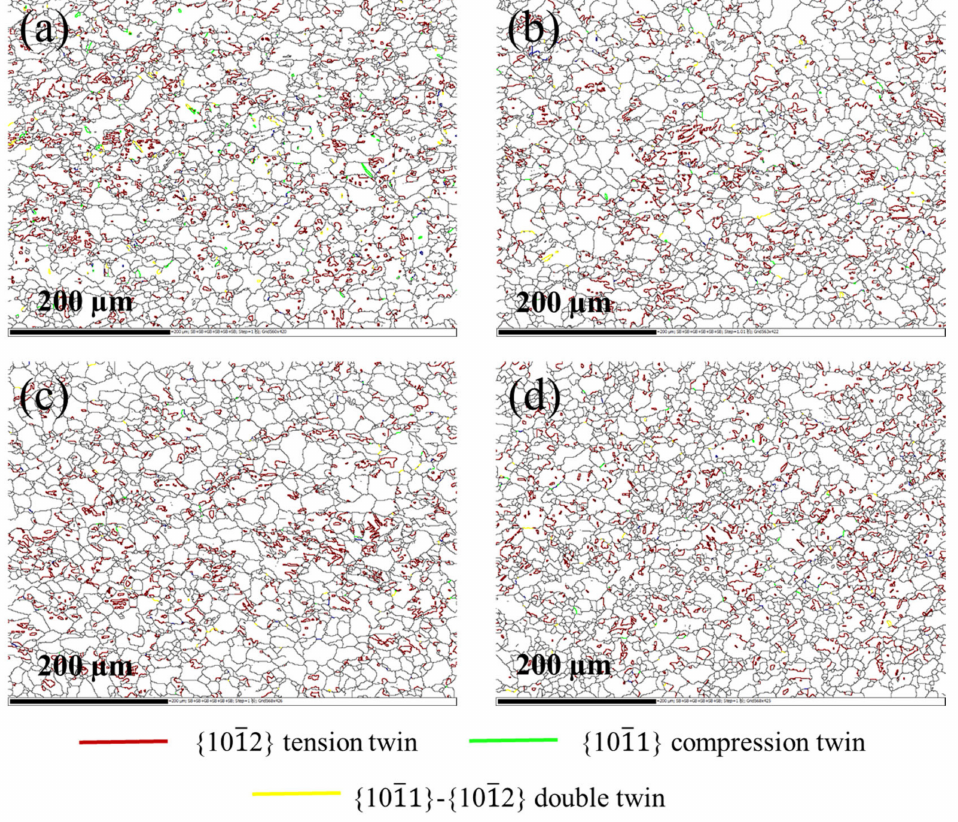
Figure 8. Twin boundary maps corresponding to the loading conditions of ( a ) 0.001 s − 1 and 293 K, ( b ) 1300 s − 1 and 293 K, ( c ) 1300 s − 1 and 213 K, and ( d ) 1300 s − 1 and 488